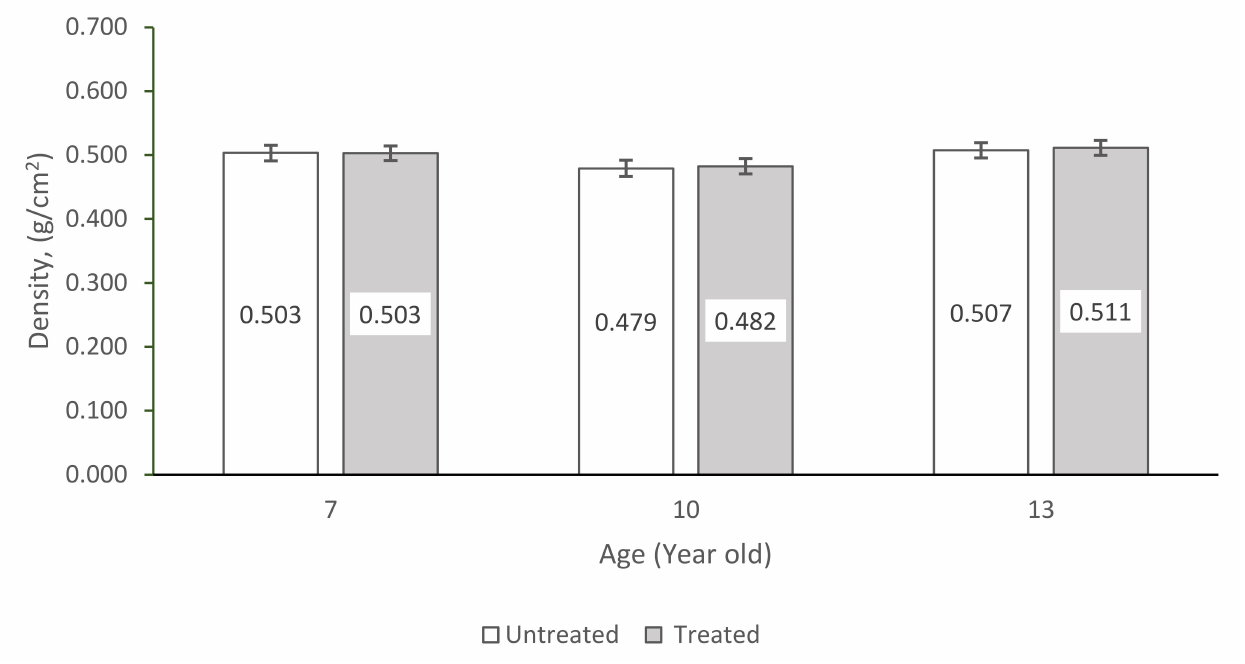
Figure 7. Density mean values of the Acacia hybrid sample compared within the age groups, grain direction, and treatment condition at air-dry